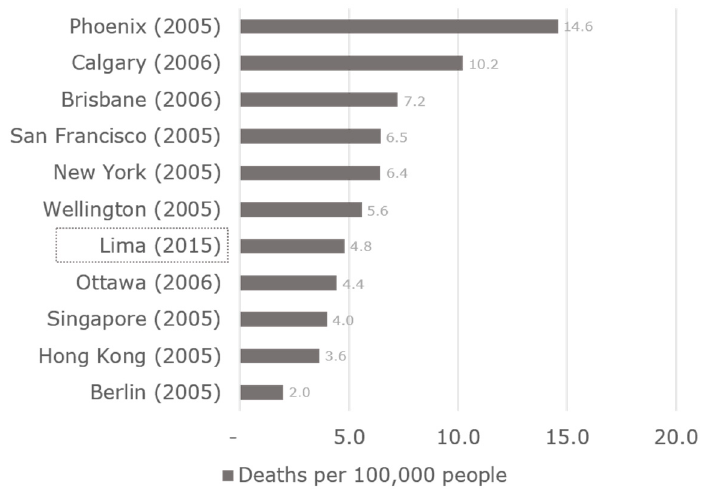
Figure 23. Total transport deaths per 100,000 people in world cities. Source: References [54,63]. Graph by authors.